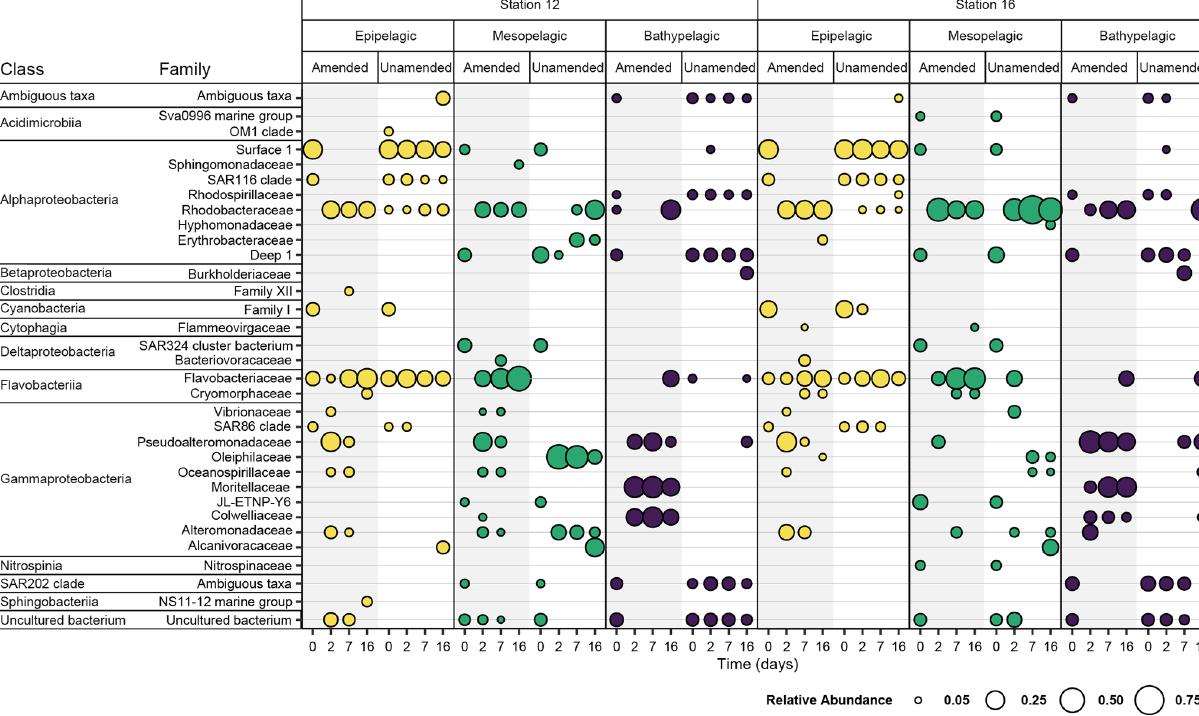
Figure 3. Bacterial families with a normalized relative abundance of 5% or more in amended and unamended mesocosms from each station and depth 0, 2, 7, and 16d after the addition of HMW organic matter to amended mesocosms. Amended values are an average of triplicate amended mesocosms, and the bubble size indicates the relative abundance (%) of each bacterial family. Note that “Ambiguous taxa” represents those sequences for which the taxonomy did not meet a consensus when compared to the reference